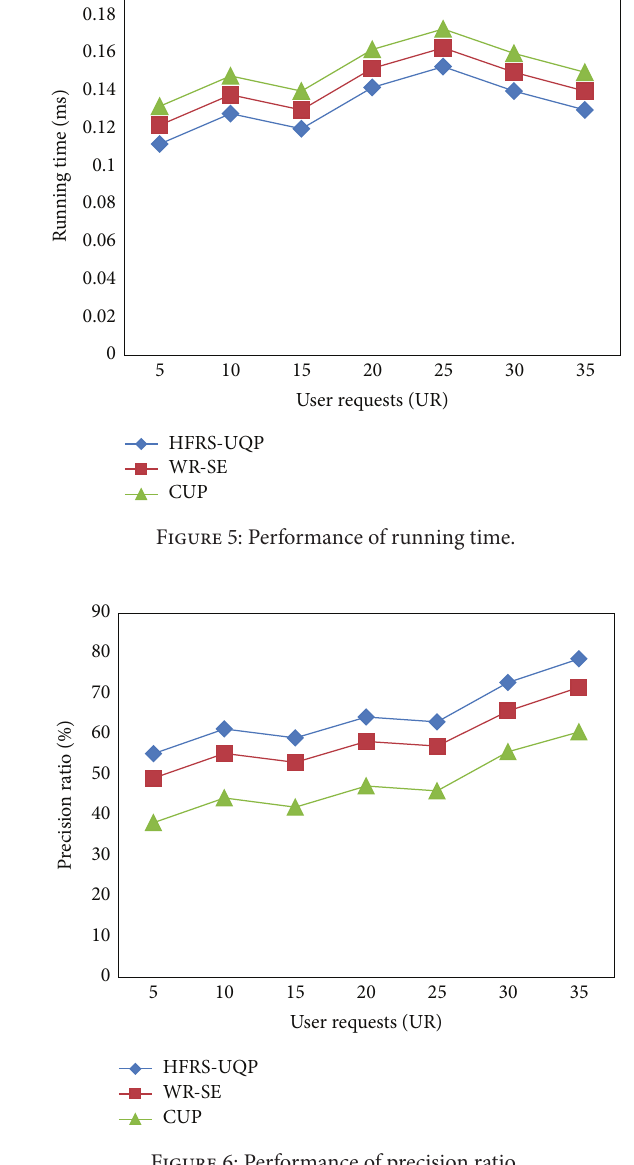
Figure 6: Performance of precision